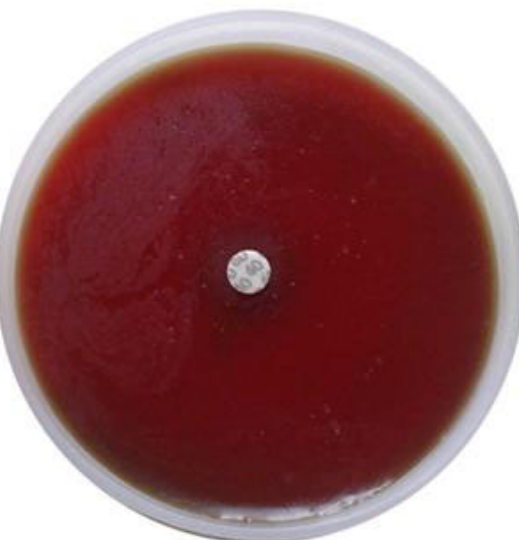
Fig. 6 - Alpha hemolytic colonies on blood agar plate growing around optochin disc, confirming the presence of Streptococcus viridians.